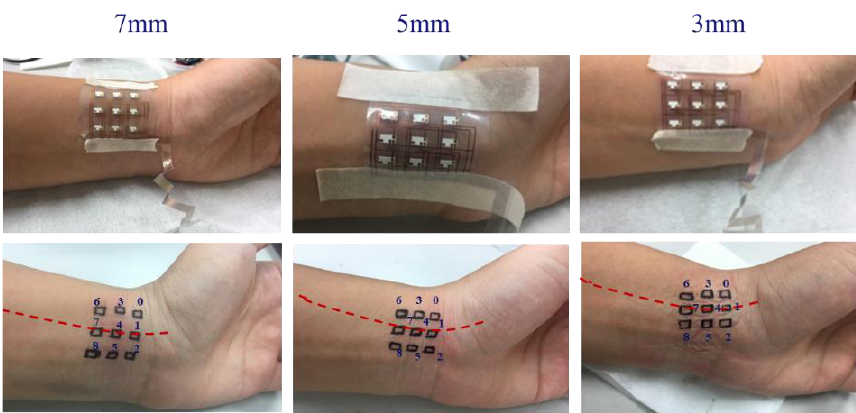
Figure 12. Photos of the sensing chip number and placement of three different pitch sensing chips. The red dotted line indicates the radial artery position and crosses the center of the sensing chips.